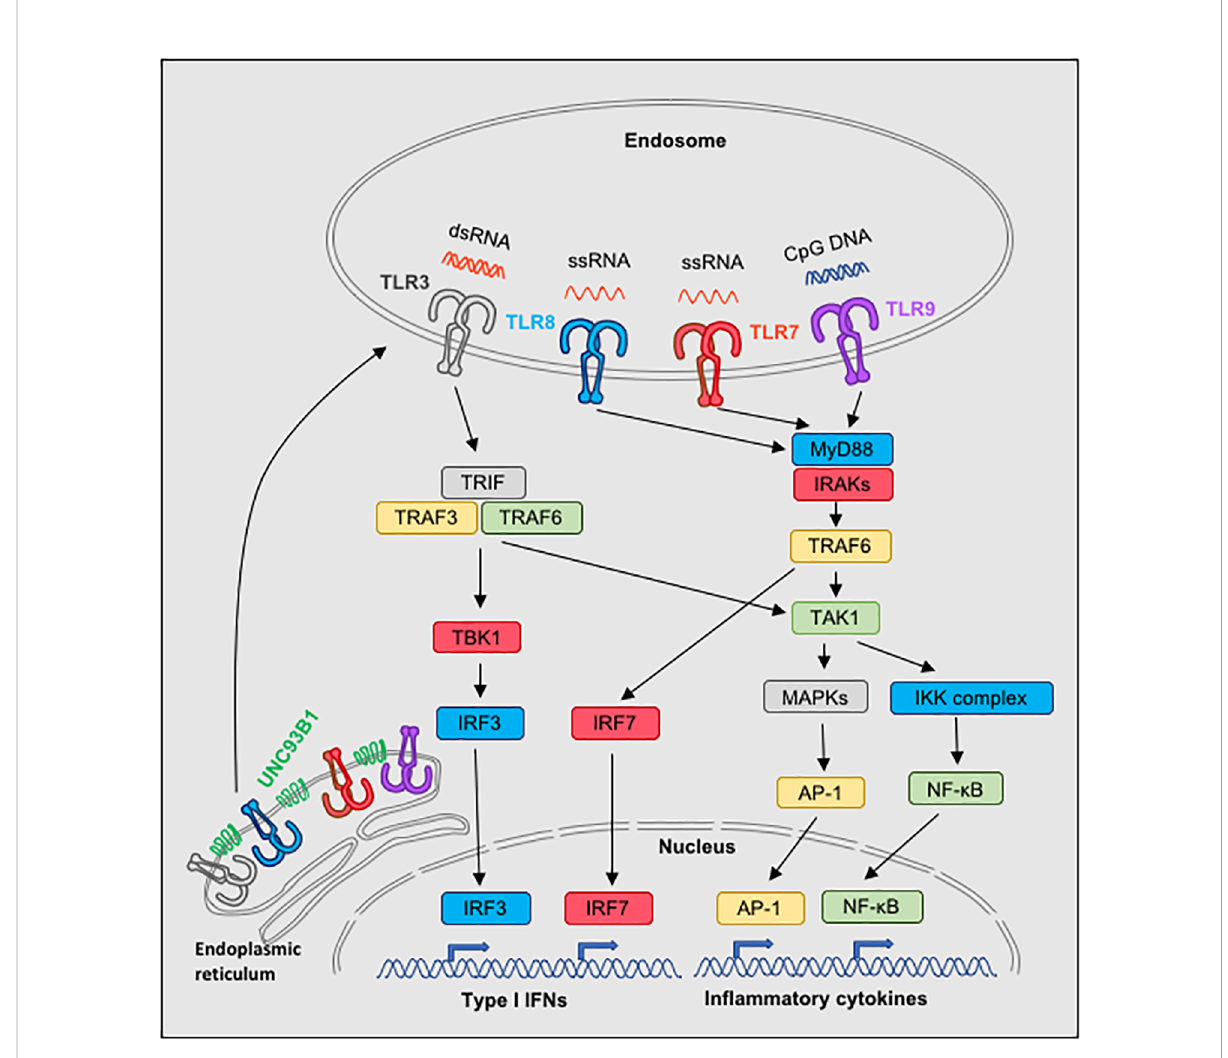
FIGURE 1 Signaling pathways of nucleic acid-sensing TLR3, TLR7, TLR8 and TLR9. Nucleic acid-sensing TLRs are translated in the endoplasmic reticulum and subsequently require the transmembrane protein UNC93B1 for exit and traf fi cking via the classical secretory pathways to endosomes. On top of UNC93B1, each TLR is associated with additional molecules and is transported to designated compartments by individual mechanisms, which can vary depending on the cell type (not illustrated). Once in endosomes and upon ligand processing and binding to the appropriate TLR, signaling pathways are activated: TLR7, TLR8 and TLR9 use the MyD88 pathway, whereas TRIF is used in the TLR3 signaling. Both MyD88 and TRIF mediate activation of NF-kB and subsequend induction of in fl ammatory cytokine genes. Moreover, MyD88 is responsible for TLR7-, TLR8- and TLR9-dependent activation of IRF7, and TRIF for TLR3-dependent activation of IRF3, which lead to the induction of type I